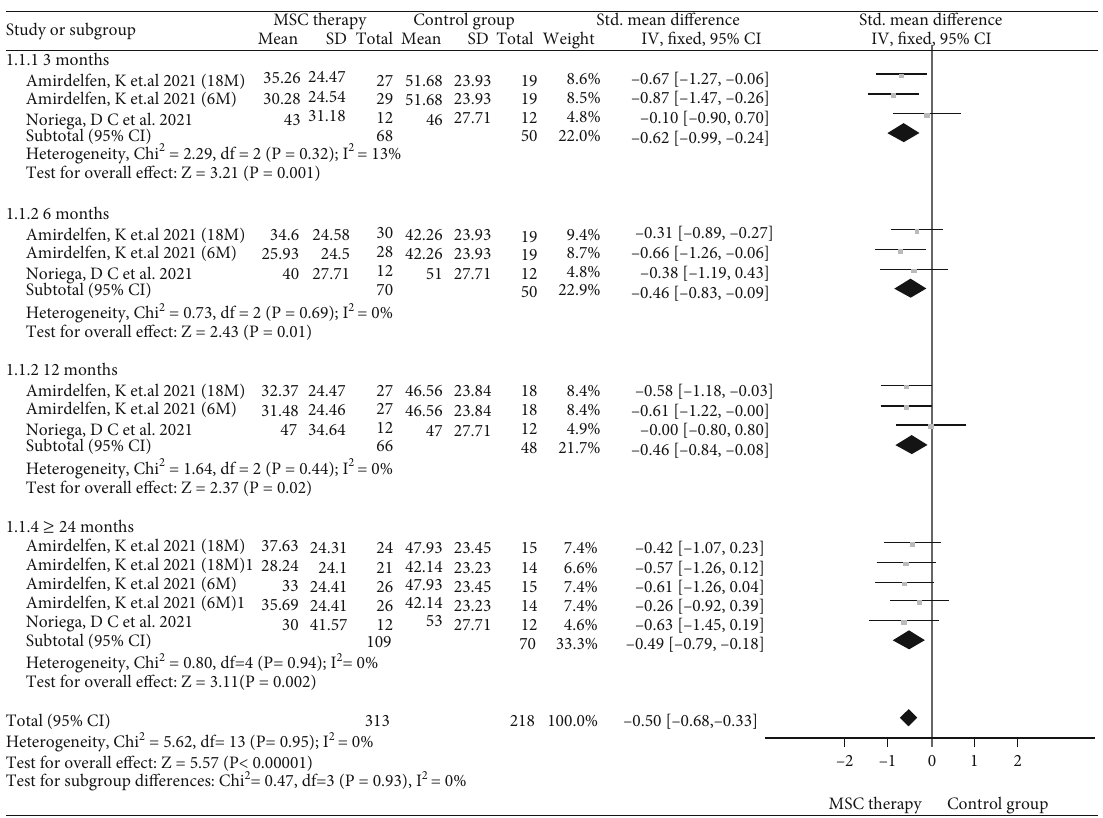
Figure 3: Forest plot of VAS scores between MSC therapy and control